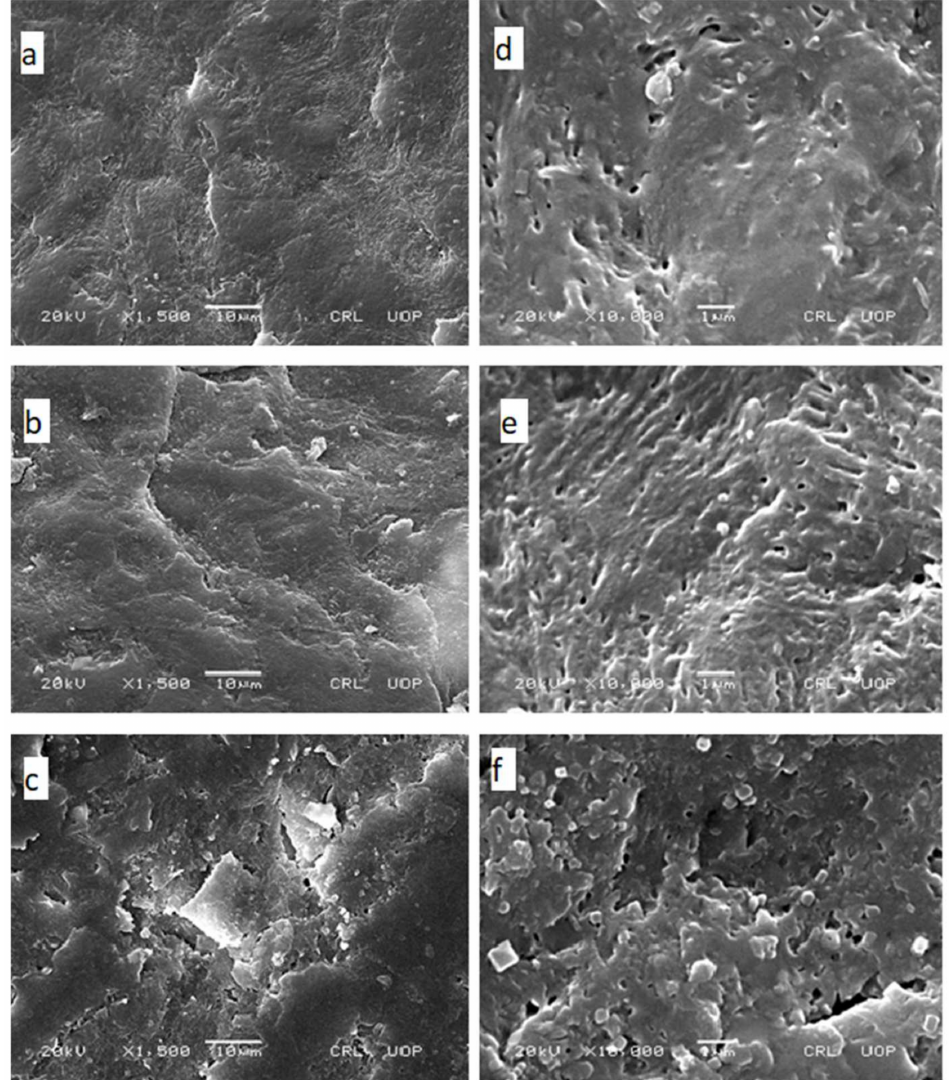
Figure 1. The impact of penetration enhancer on the surface morphology of nail observed under the electron microscope at low (1500 × : left-side images) and high (10,000 × : right-side images) magnification. Untreated nail ( a , d ), nail hydrated in water for 72 h ( b , e ) and nail hydrated in 5% TGA solution for 72 h ( c , f